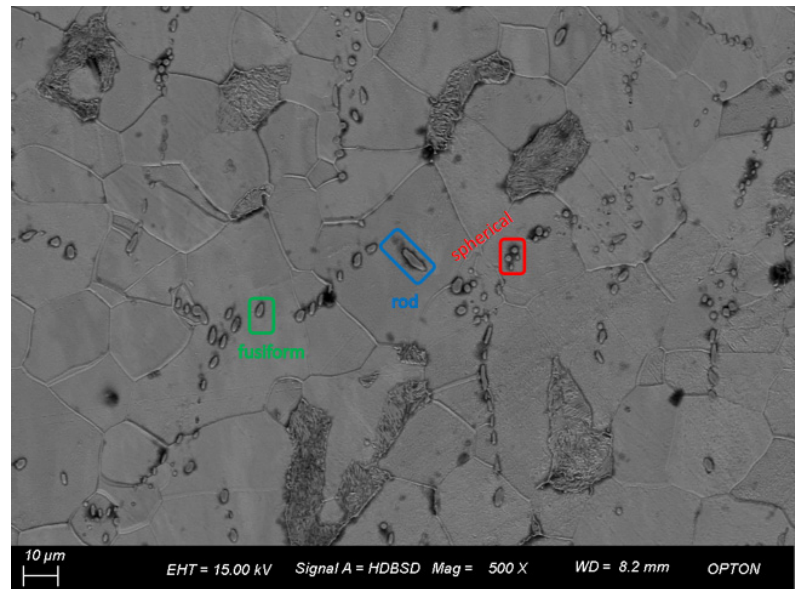
Figure 4. Morphology and quantity distribution of No. 1 steel inclusions.